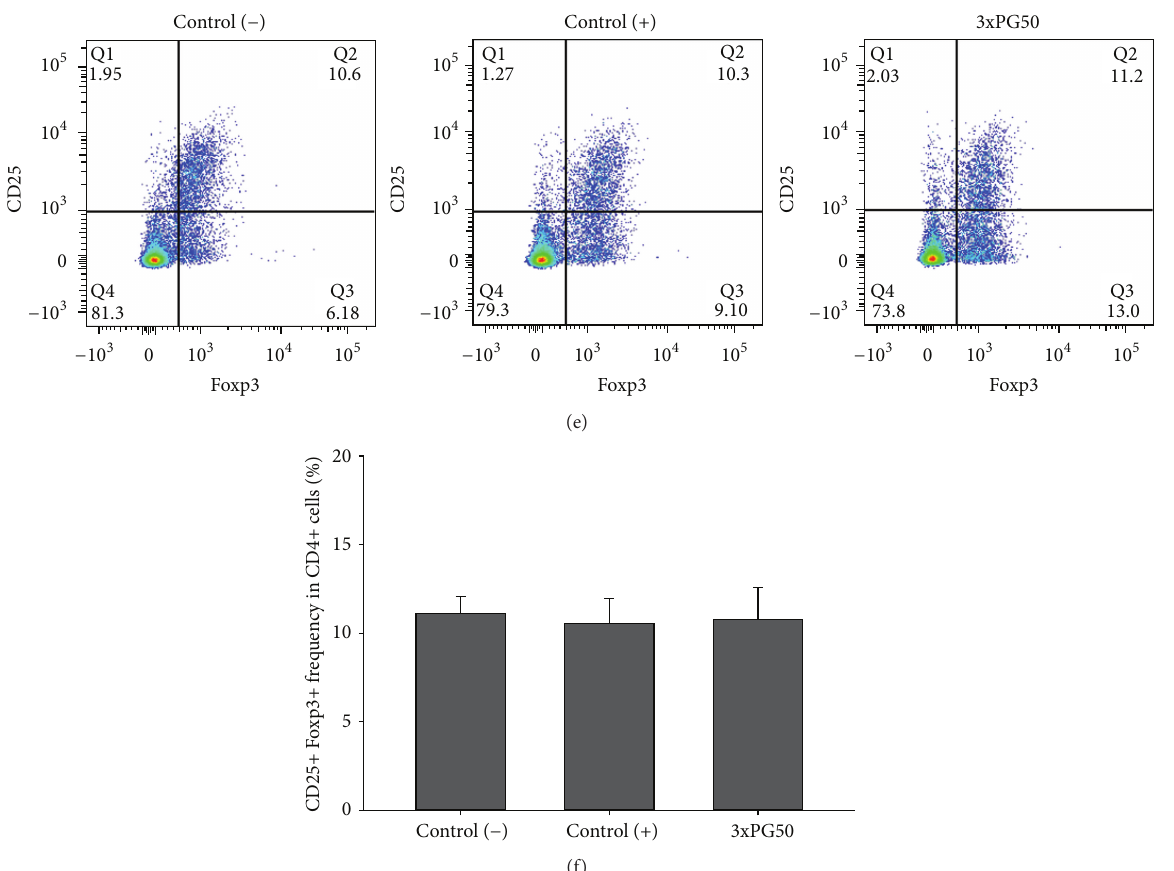
Figure 3: Effect of previous PG inoculation on the frequency of splenic dendritic cells (DCs) and regulatory T cells (Tregs). (a) Gate strategy for DCs in a control ( − ) sample. (b) Representative flow cytometry analysis for DCs frequency in spleen. (c) MHCII+ CD80+ cell frequency in total CD11+ cells. (d) Gate strategy for Tregs. (e) Representative flow cytometry analysis for Tregs frequency in spleen. (f) CD25+ Foxp3+ cell frequency in total CD4+ cells. Control ( − ): healthy group not previously injected with PG; control (+): arthritic group not previously injected with PG; 3xPG50: arthritic group previously injected with three doses of PG (50 𝜇 g). Six to ten animals per group from one representative experiment of two performed. ∗ 𝑝 < 0.05